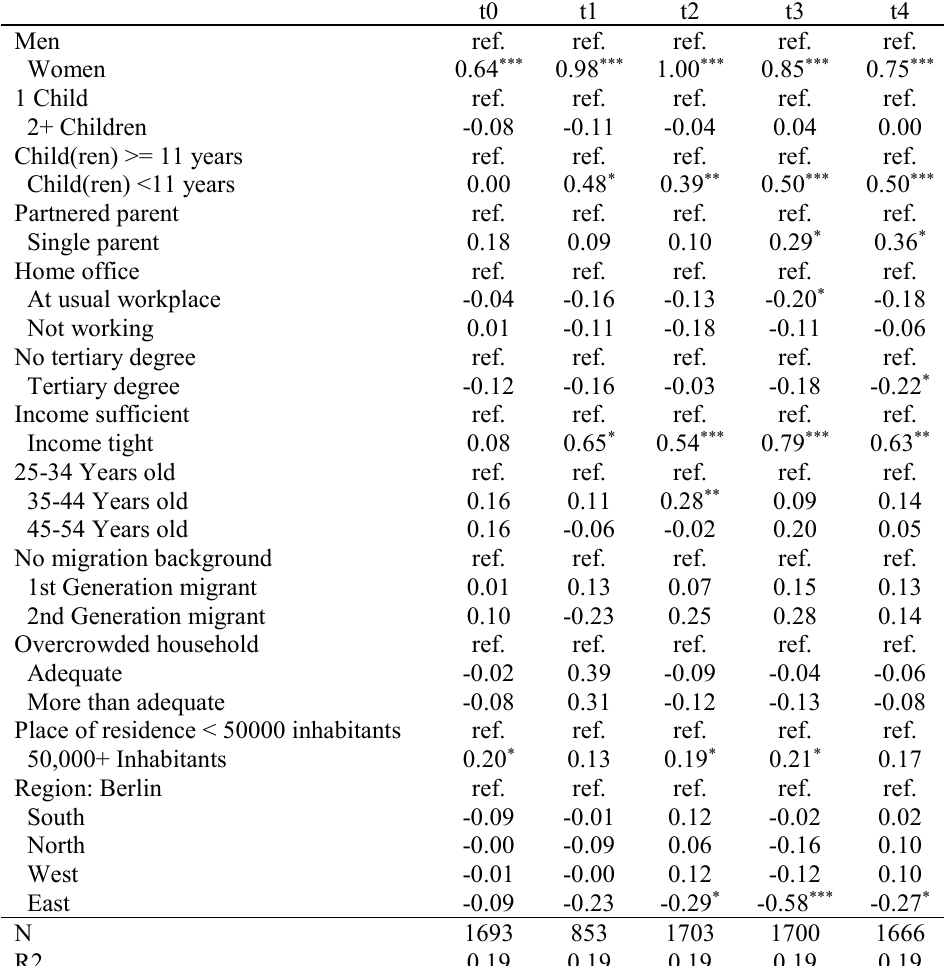
Note: The table presents marginal effects and 95% confidence intervals based on OLS regressions with clustered, robust standard errors (as shown in Table 2). The psychological distress scale ranges from 0 to 8. Higher values indicate higher levels of psychological distress. The model was fully interacted with measurement time points. The sample size at t1 is smaller than at the other time points, because the psychological distress/parenting stress questions were only integrated into the survey after its initial